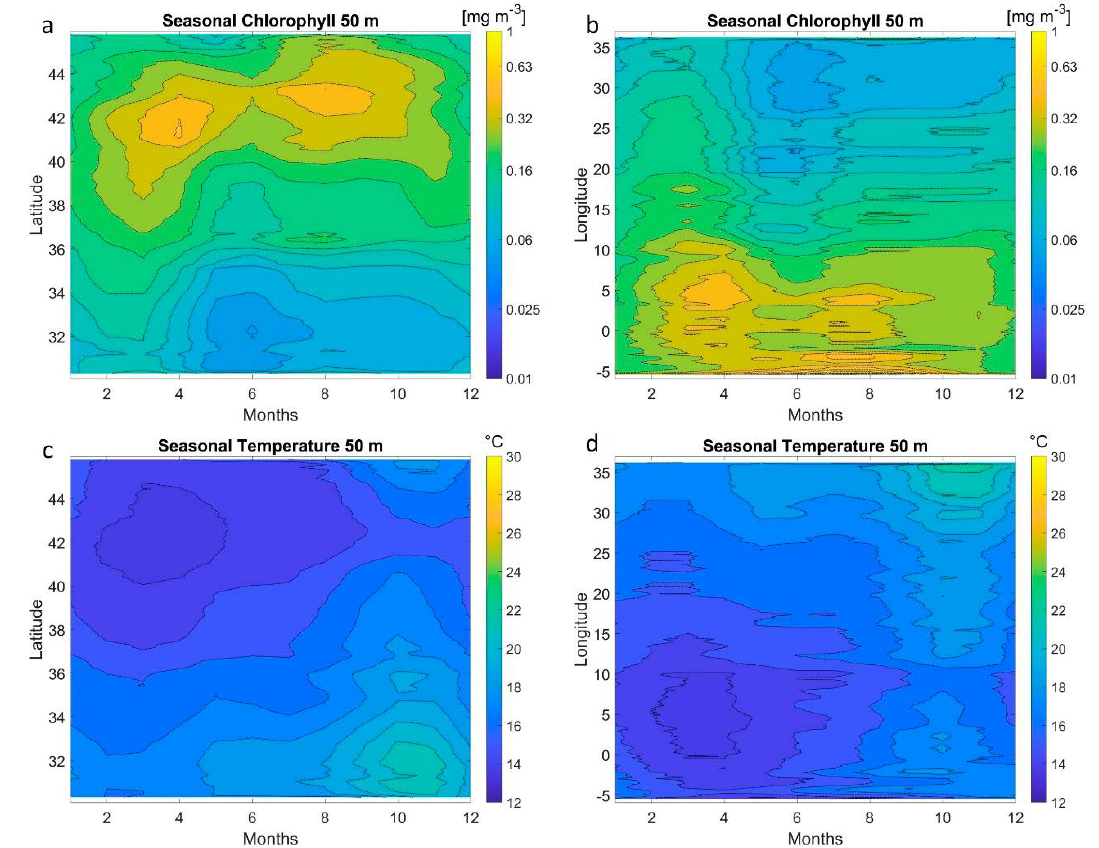
Figure 13. An example of MLP basin reconstruction from monthly satellite data at 50 m of depth. On the left panels a contour plot of the longitudinal chlorophyll ( a ) and temperature ( c ) means along the year (on x-axis) is shown. On the right, a corresponding contour plot of latitudinal chlorophyll ( b ) and temperature ( d ) means is provided.